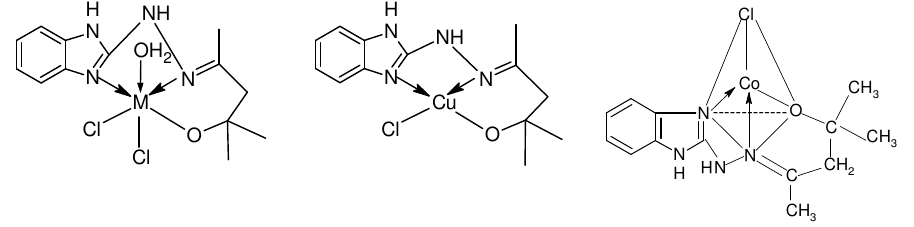
Figure 4 . Structure of Cu(II) complex